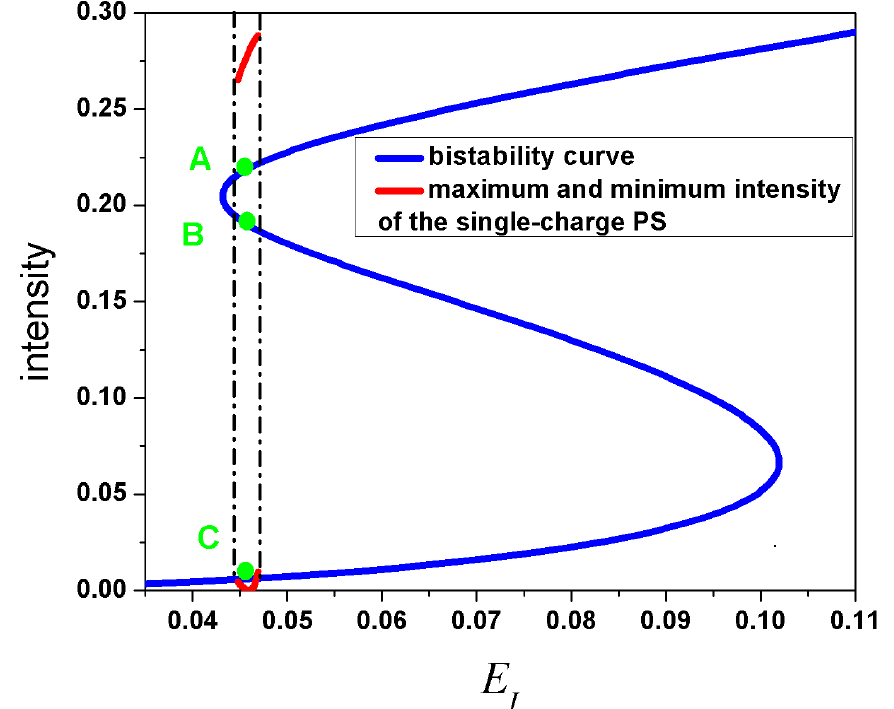
Figure 1. Intensity of the stationary states for the choice of the parameters µ = 1.1, α = 3, θ = − 2.7, σ = 0.3 and b = 50 as a function of the injected field amplitude E I . The blue curve is the homogeneous solution. The phase solitons, whose maximum and minimum intensity are shown in red, exist in the interval delimited by the dashed vertical lines. In that region the homogeneous solution is triple valued. The upper state A is stable, the state B in the negative slope branch is unstable as usual, the lower state C is an unstable